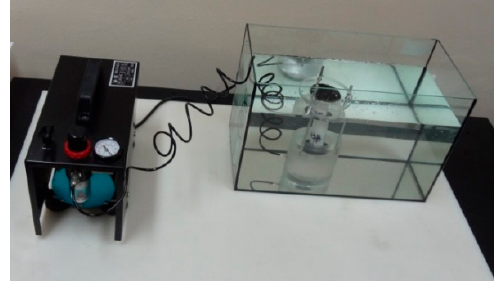
Figure 3. Test stand for leak-tightness testing.